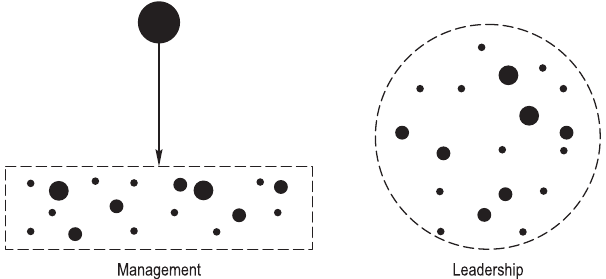
Fig 2. The difference between the concepts of management and